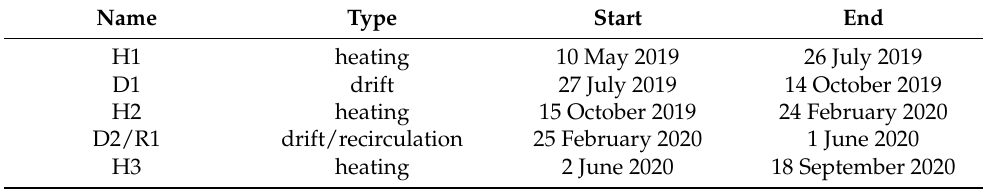
Table 4. Name, type, and duration of operating periods of the experimental